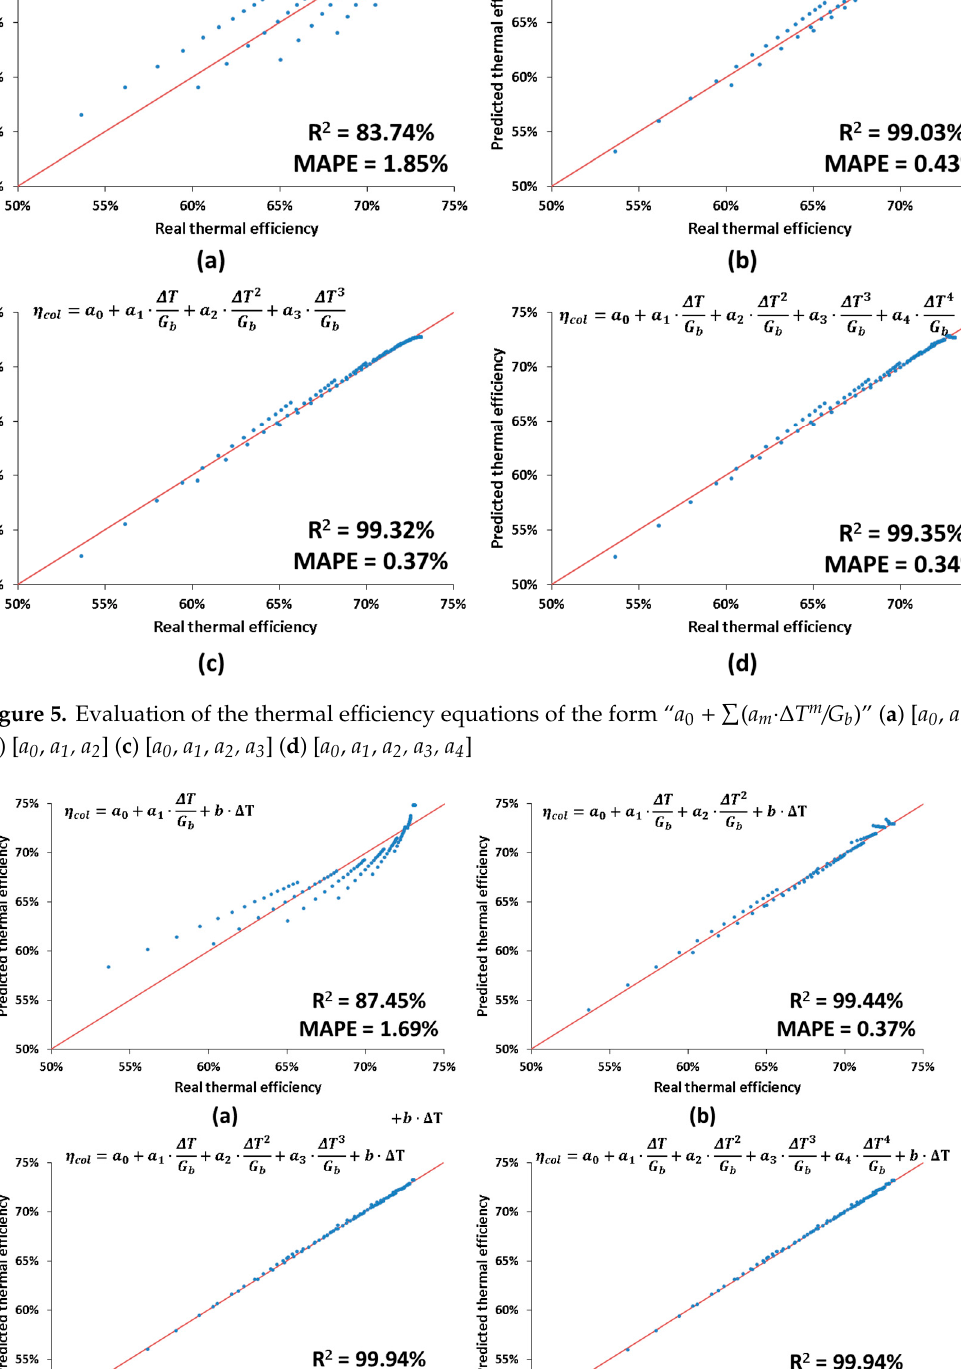
Figure 6. Evaluation of the thermal efficiency equations of the form “ a 0 + ∑ ( a m ∙Δ T m /G b ) + b ∙Δ T ” ( a ) [ a 0 ,